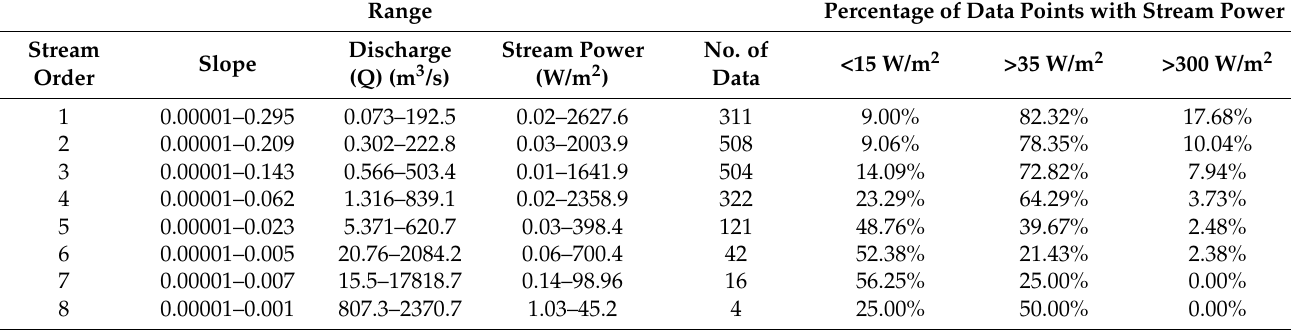
Table 3. Number of data, range of parameters, and stream power with the percentage of data points above or below power thresholds per stream order.